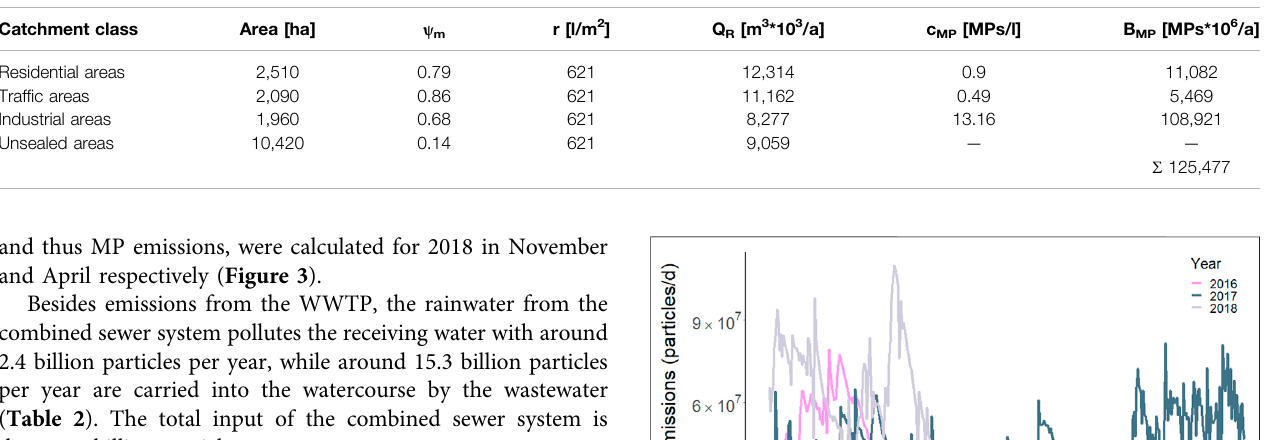
TABLE 3 | Microplastic (MP) emission (B MP ) due to stormwater runoff separated according to the catchment class. Accumulated results for the catchment area of the tributaries as well as areas connected to stormwater outlets (grey area Figure 2 ) are shown. Microplastic concentrations ( c MP ) were obtained from Liu et al. (2019). Runoff coef fi cients ( ψ m), annual rainfall (r), and rainfall runoff (Q R ).